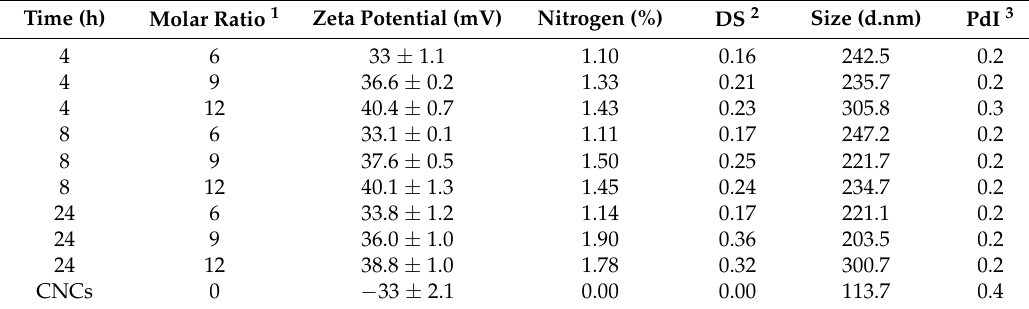
Table 1. Conditions and results of the etherification reaction of CNC with CHPTAC.